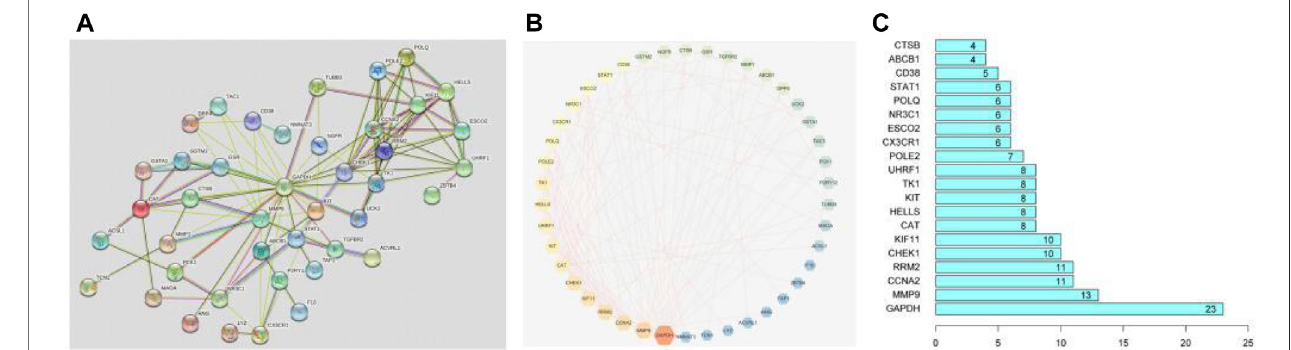
FIGURE 3 | PPI network and its analysis.